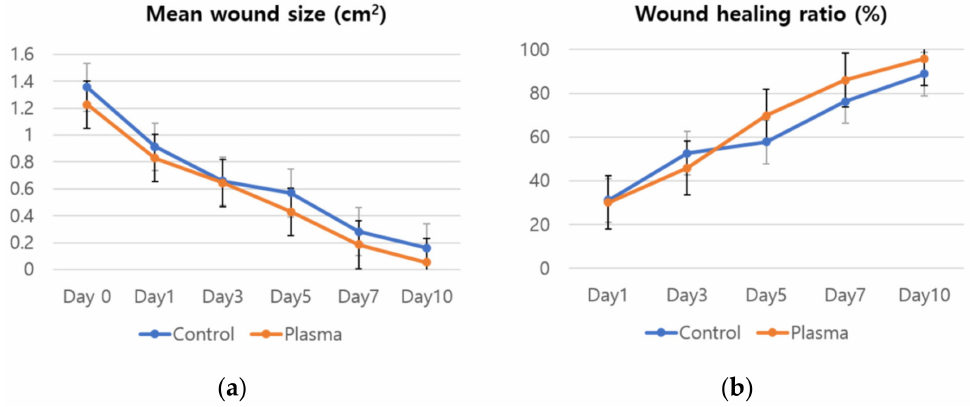
Figure 6. ( a ) Mean wound size and ( b ) wound healing ratio of the plasma-treated and control groups by